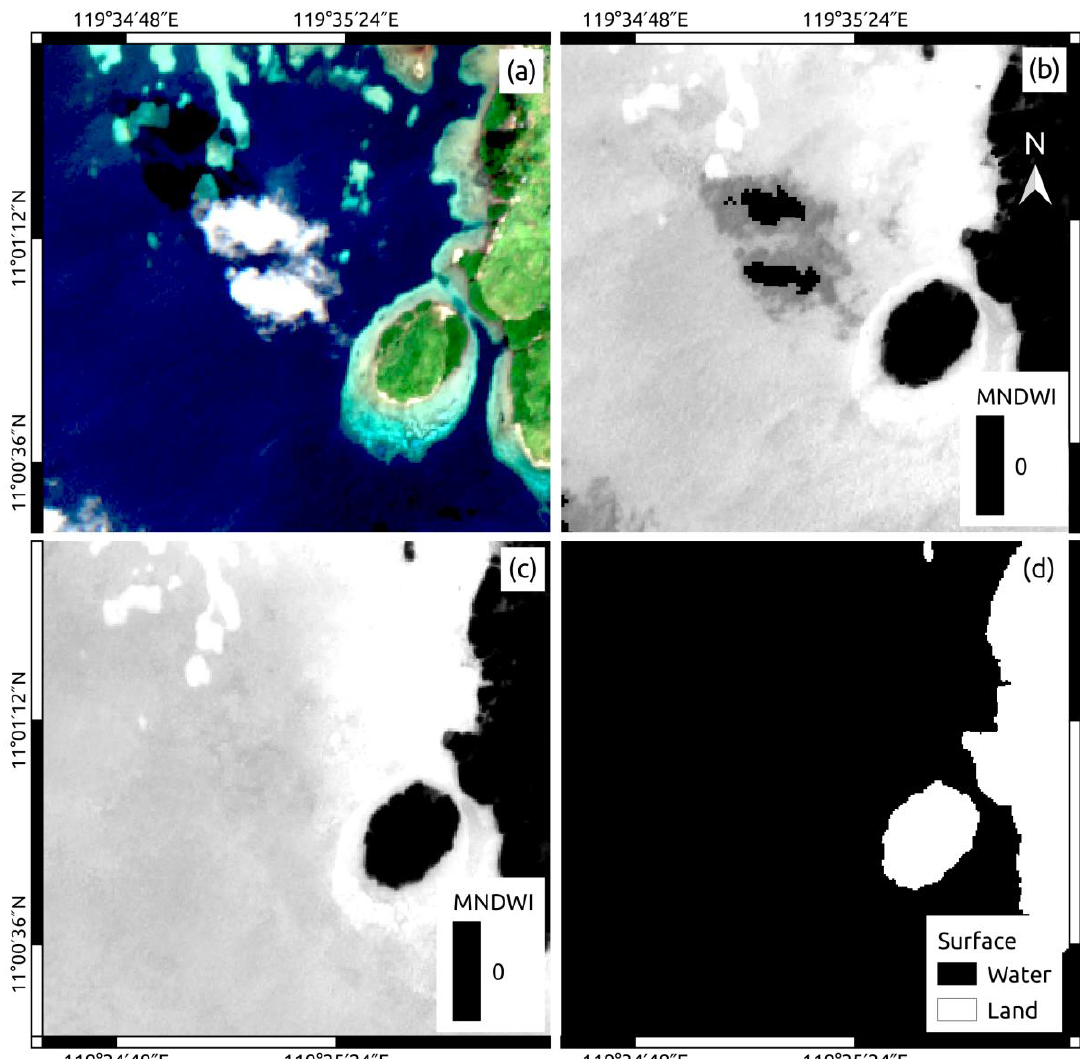
Figure 4. Sentinel-2 MSI land mask processing stages: ( a ) a fragment of Sentinel-2 MSI image in colour, where Band2 is shown in blue, Band3 in blue, and Band4 in red; ( b ) a map of modified water index values (Equation (1)) derived from one Sentinel-2 scene; ( c ) a composite map of water index values; ( d ) a land – water mask where the land is shown in white and the water in black.